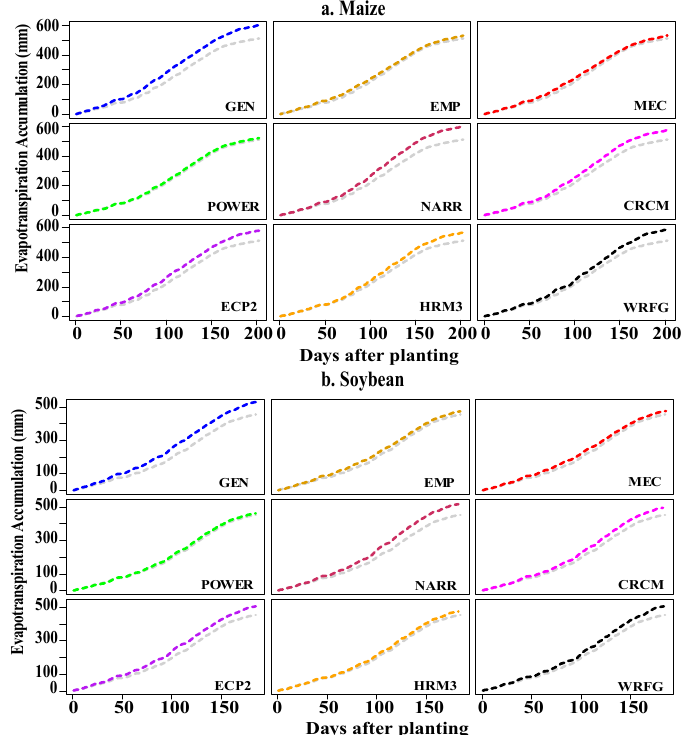
Figure 9. Growing season accumulated crop evapotranspiration (ETAC) simulated from the different sources of estimated solar radiation (color) and observations (gray) during 1993 for ( a ) maize and ( b ) soybean. Note the change in the scale of the vertical axis for maize and soybean. See Figure 2 for definition of abbreviations. For both crops, planting occurred on April 1. For reference, the timing of crop stages for the 1993 simulations using observed radiation, in terms of days after planting, for maize (soybean) was 86 (74) for anthesis and 172 (142) for